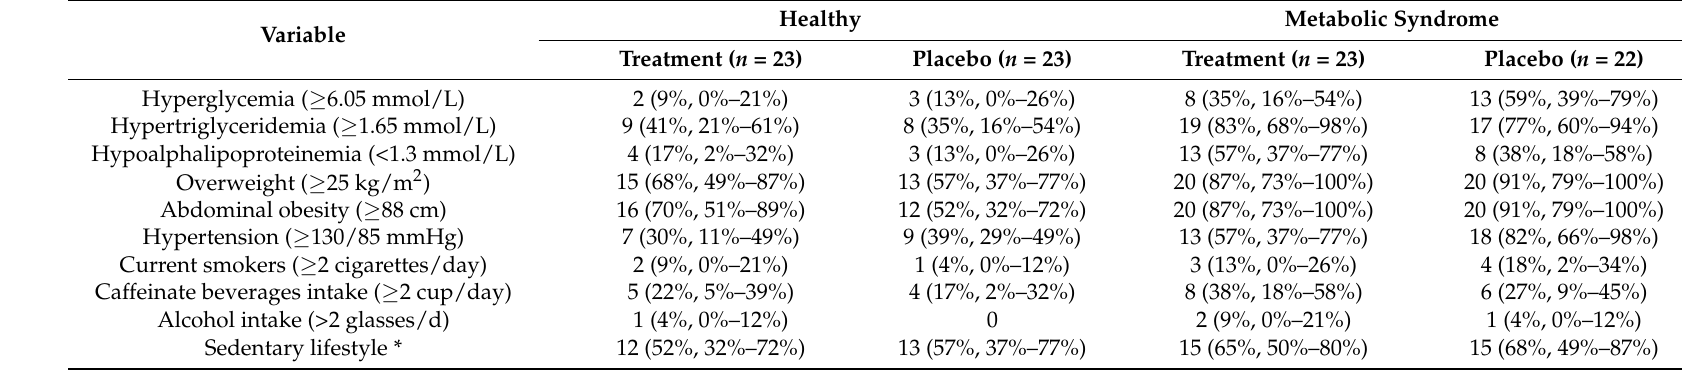
Table 2. Percentage of study women with metabolic alterations according to National Cholesterol Education Program Adult Treatment Panel III (NCEP-ATP III) criteria and pro-oxidant factors by study group.